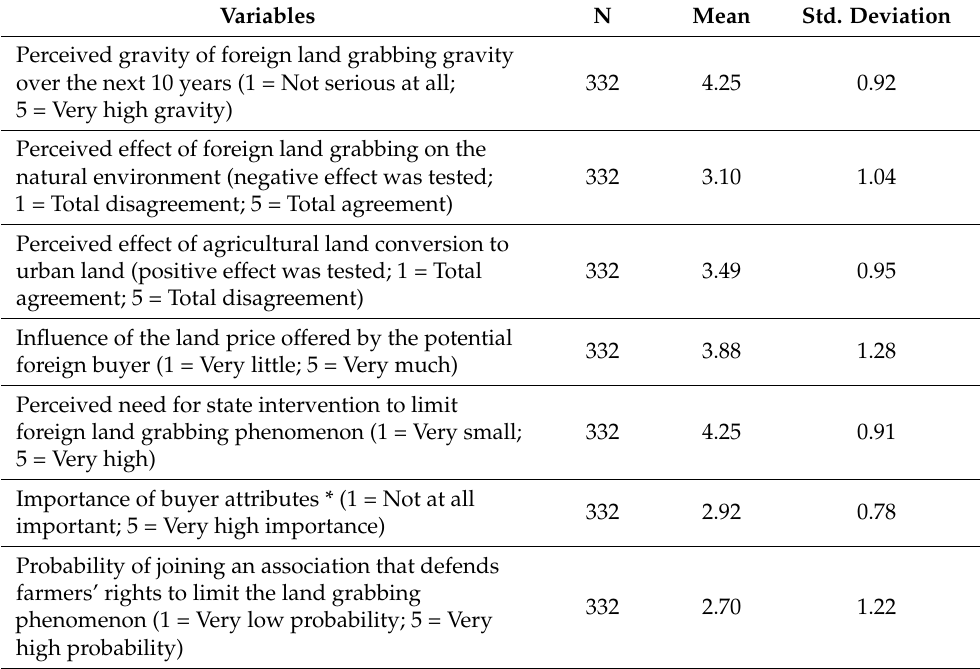
Table 3. Descriptive statistics of investigated